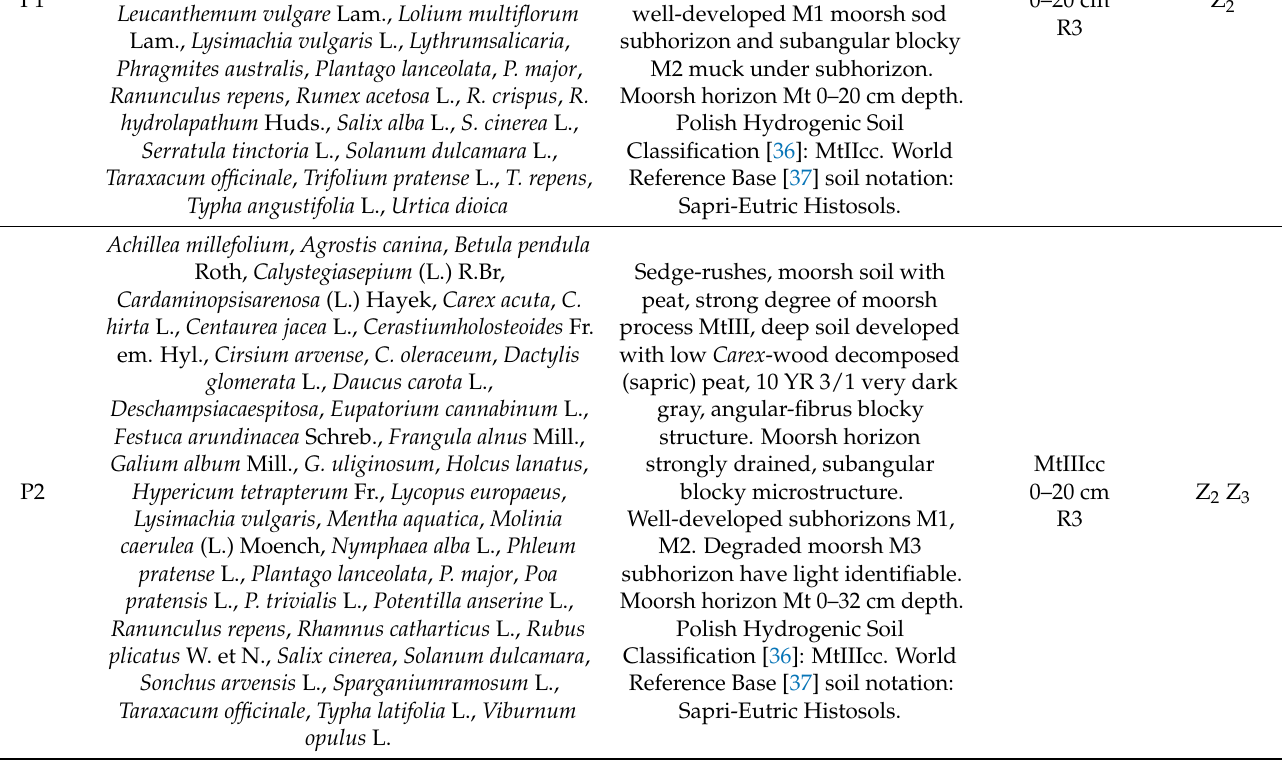
Type of Stage of Soil Moorsh Moorshifica- Forma- tion, Degree of Decomposition